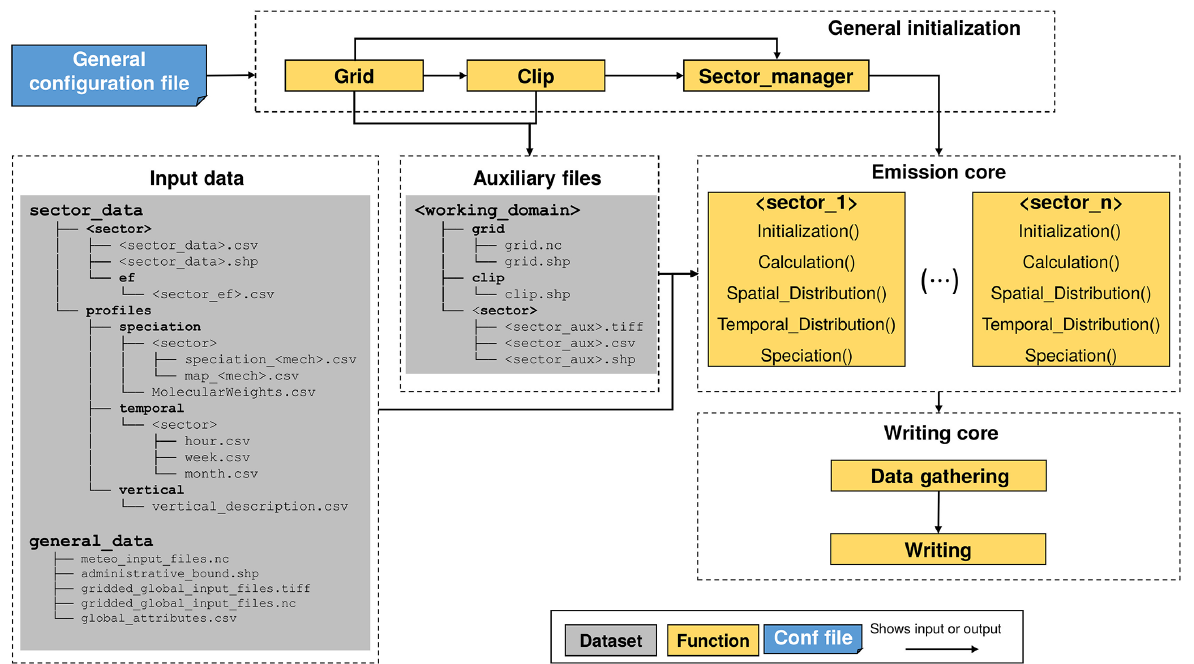
Figure 1. Schematic representation of the general structure of HERMESv3_BU. All the parameters described by the user in the general configuration file (e.g. working domain, execution dates, input data paths) are used to execute the initialization process (i.e. creation of working grid, clip polygon and auxiliary files and distribution of the computational resources). Once the general initialization is finished, HERMESv3_BU starts the execution of the emission core of the model. For each pollutant sector, and considering the input data provided by the user, HERMESv3_BU performs a (i) sector initialization, (ii) sector calculation, (iii) spatial mapping, (iv) temporal distribution and (v) speciation. Once the emission estimation of all sectors is finished, the writing core proceeds to gather all the data and writing it according to the atmospheric chemistry output format selected by the